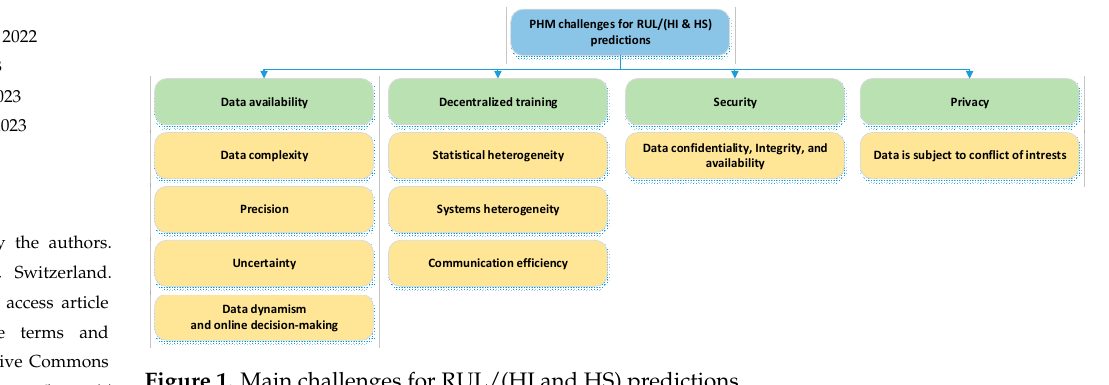
Figure 1. Main challenges for RUL/(HI and HS)